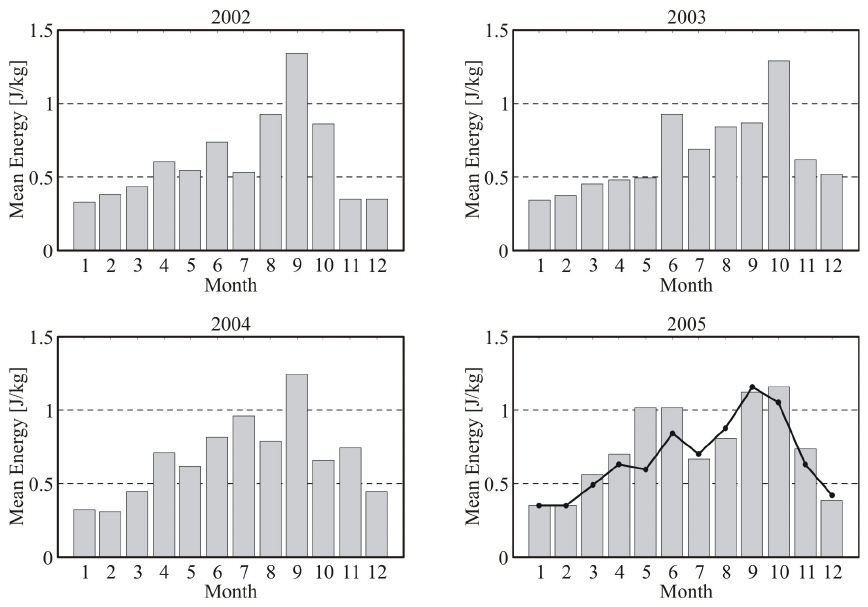
Fig. 2. Monthly means of E p for each year of the study. The black squares in the graph for year 2005 represent the monthly averages over the four years.